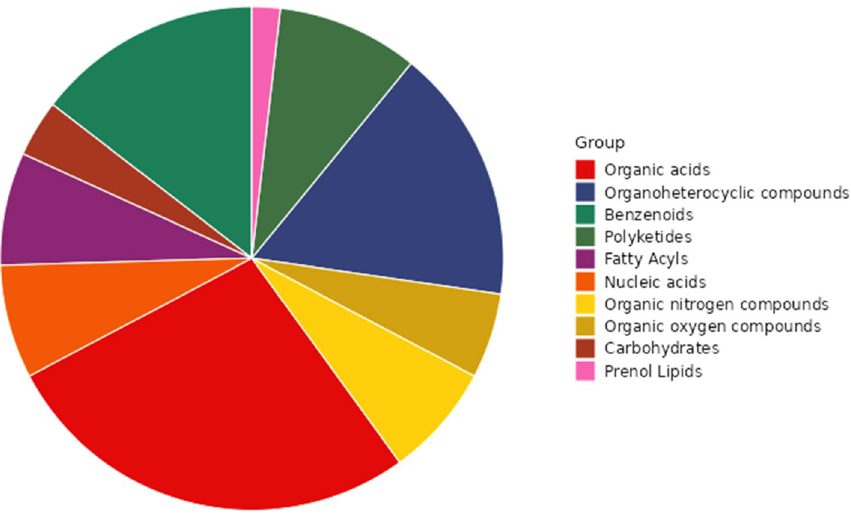
Figure 3. Classification of differential